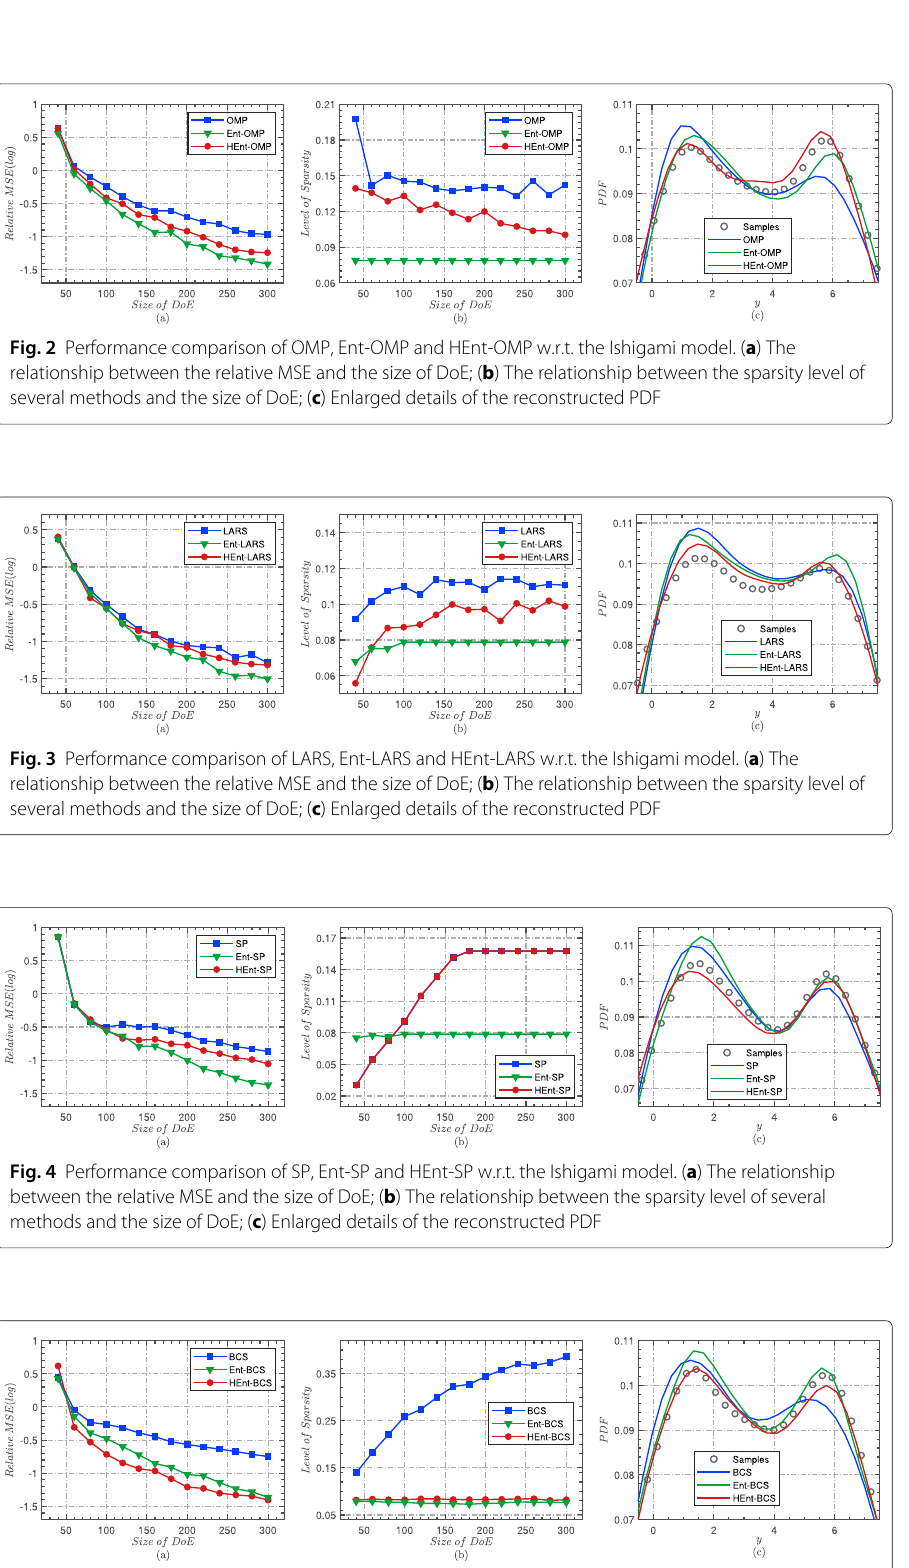
Fig. 5 Performance comparison of BCS, Ent-BCS and HEnt-BCS w.r.t. the Ishigami model. ( a ) The relationship between the relative MSE and the size of DoE; ( b ) The relationship between the sparsity level of several methods and the size of DoE; ( c ) Enlarged details of the reconstructed